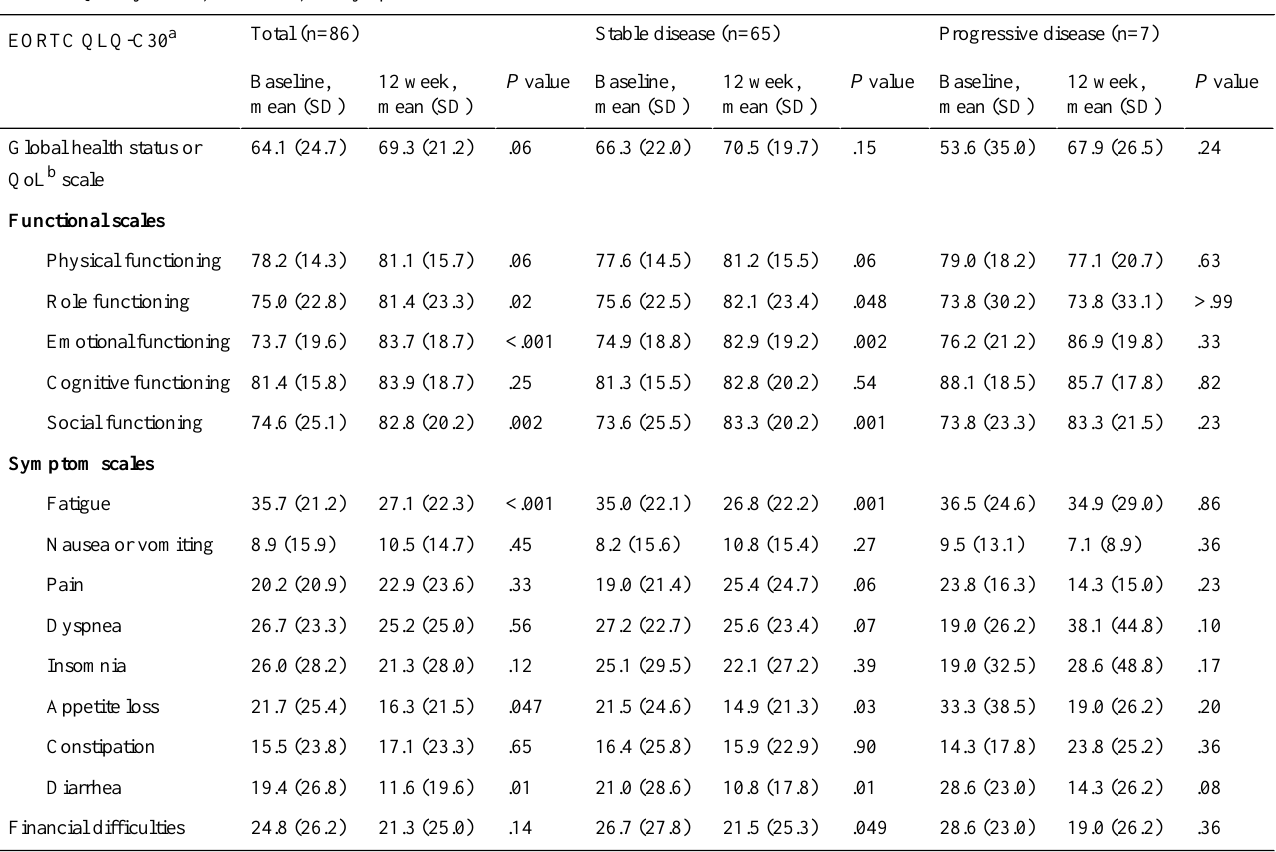
Table 3. Quality of life, functional, and symptom scale.